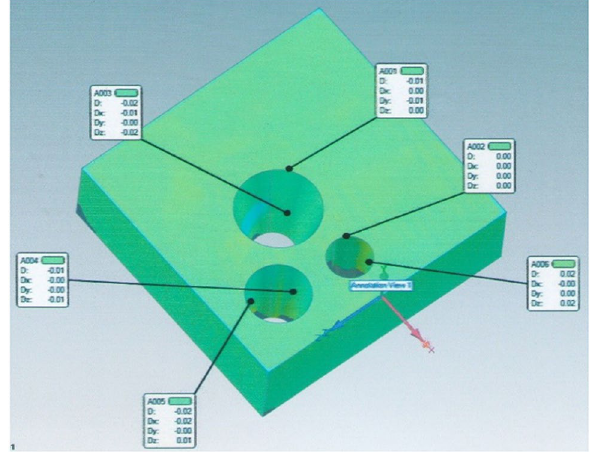
Fig. 7 CMM results of a test specimen